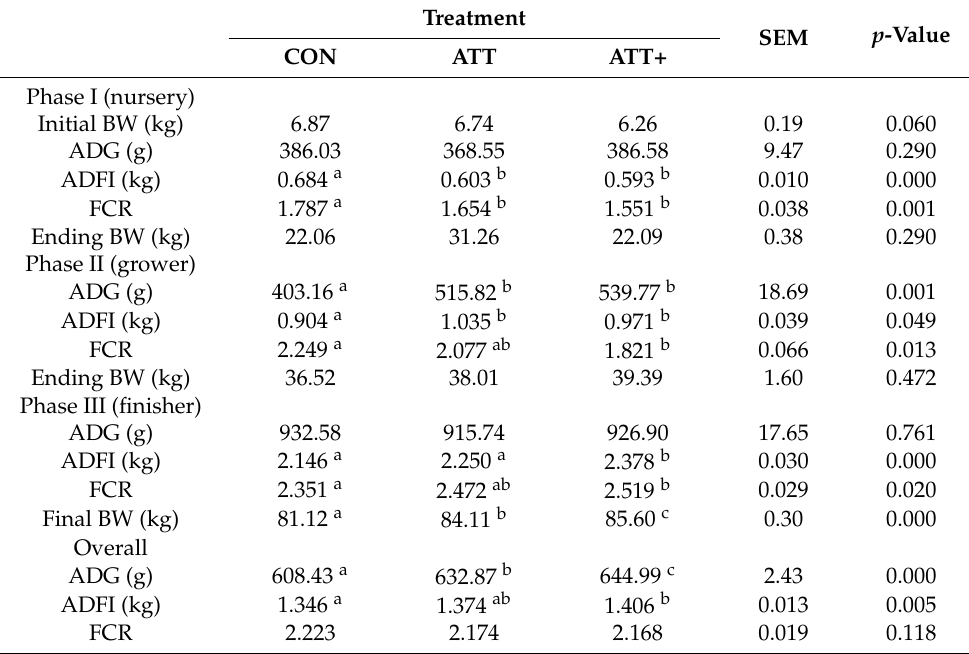
Table 3. The effect of the treatment on the growth performance characteristics of pigs in Farm B ( n = 12/treatment).